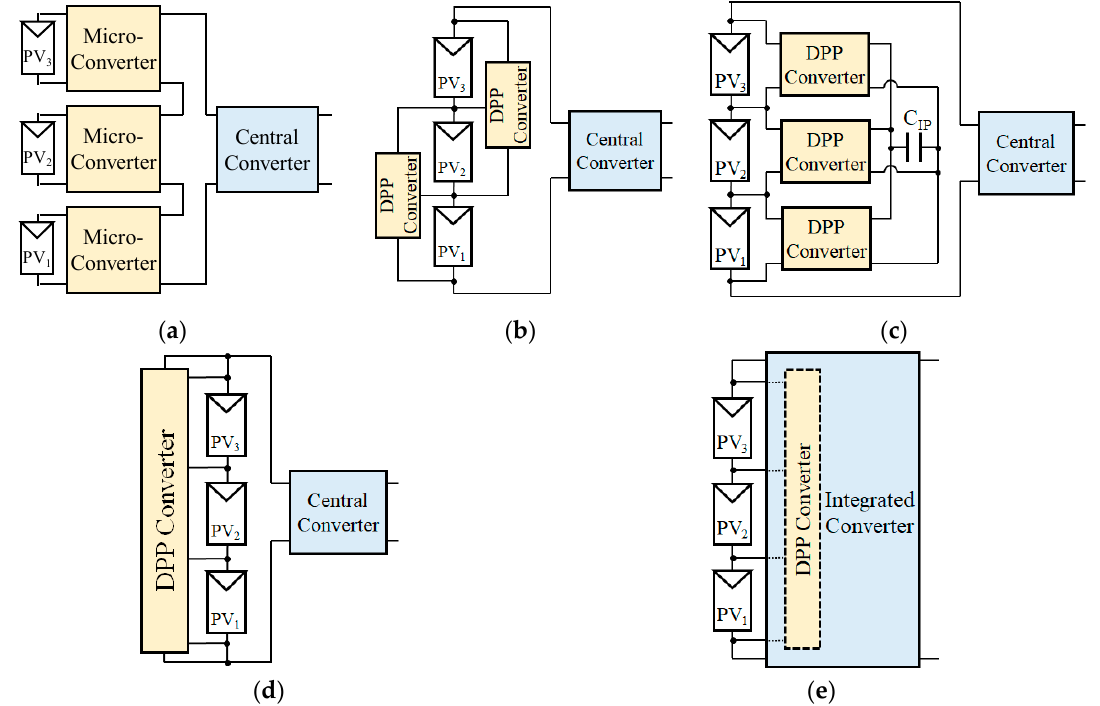
Figure 3. ( a ) Distributed MPPT system, ( b ) DPP converters for adjacent modules, ( c ) DPP converters with isolated port, ( d ) DPP converter between string and modules, ( e ) integrated converter.